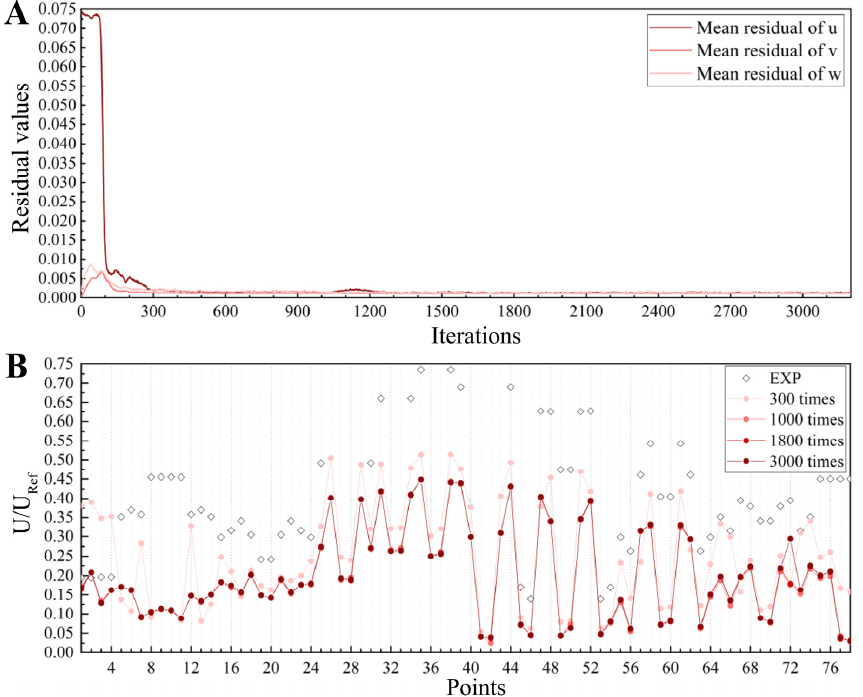
Figure 9. ( A ) Residual values obtained by GH_Wind simulations; ( B ) comparison of wind velocity ratio of measurement points at pedestrian level obtained by running different iterations. (The reference wind velocity 𝑈 (cid:3045)(cid:3032)(cid:3033) is 6.65 m/s.)